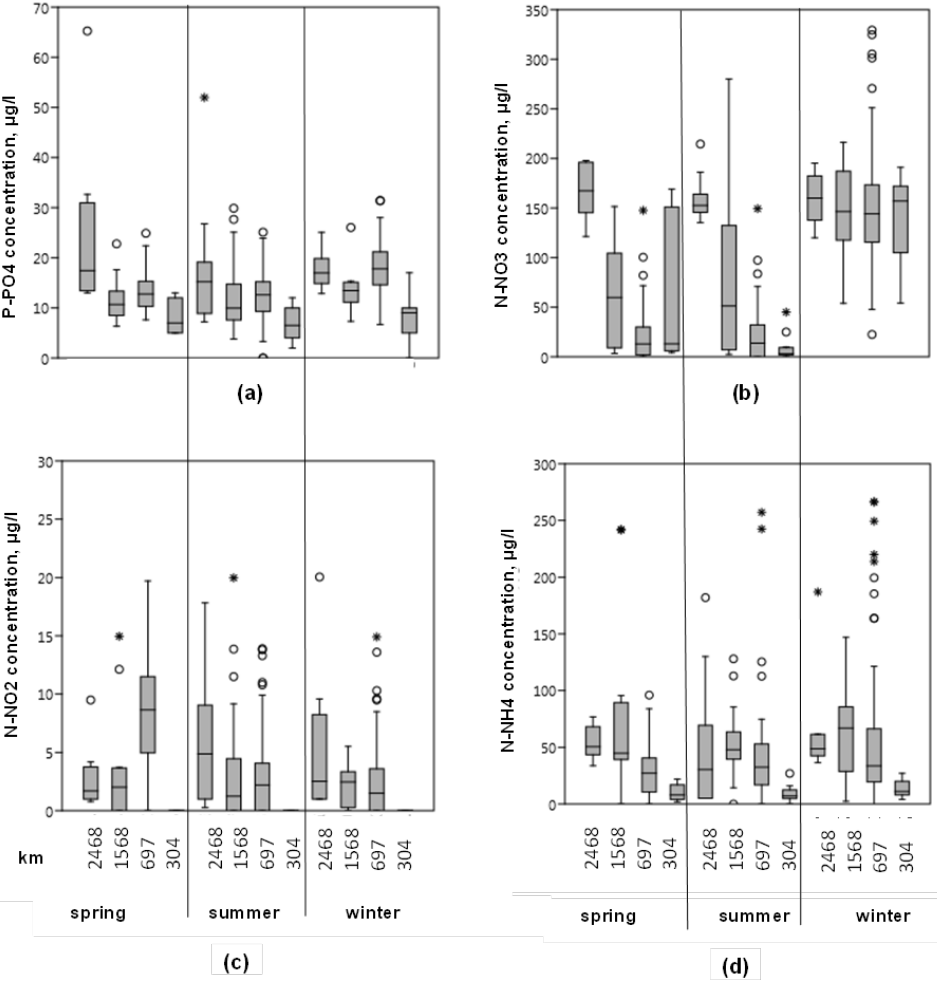
Figure 2. The nutrient content in the water of the Yenisei River at different latitudes and hydrological seasons: phosphate concentrations ( a ), nitrate concentrations ( b ), nitrite concentrations ( c ) and ammonium concentration ( d ). Numbers correspond to the distance to the outlet in km: 2468 km — Krasnoyarsk (56.0° N), 1568 km — Zotino (60.9° N), 697 km — Igarka (67.4° N), 304 km — Dudinka (69.2° N). Table 3. Total dissolved inorganic nitrogen (DIN = NO 3 + NH 4. ) and the N:P molar ratio in the water of the Yenisei River in different hydrological periods in the longitudinal direction.